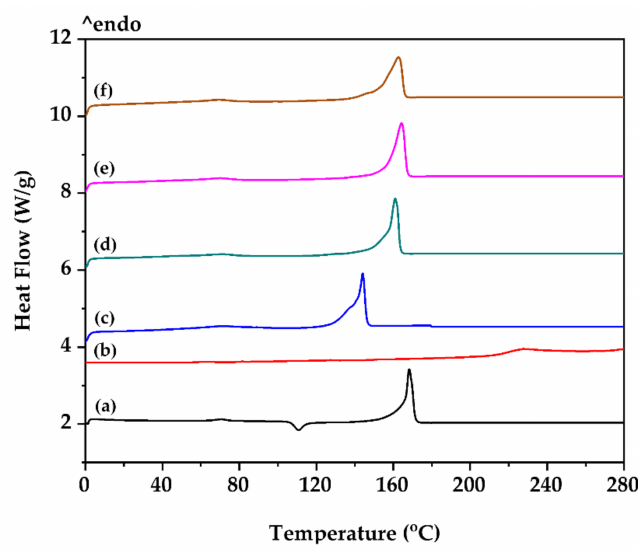
Figure 6. DSC thermograms (2nd scan) of PLA and P(MLA20- g -LLA) with composition ratio of PMLA:LLA of: 1:30, 1:50, 1:300, and 1:600 w / w : ( a ) PLA; ( b ) PMLA 20 ; ( c ) P(MLA20- g -LLA) 1:30 ; ( d ) P(MLA20- g -LLA) 1:50 ; ( e ) P(MLA20- g -LLA) 1:300 ; and ( f ) P(MLA20- g -LLA) 1:600